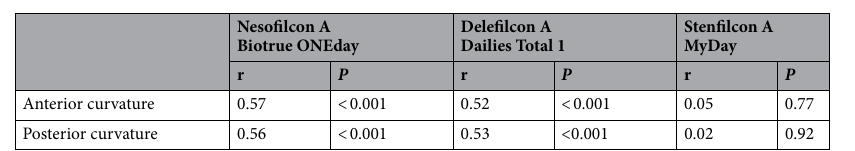
Table 5. Pearson’s correlation coefficient (r) for the mean keratometry value of the cornea and change in the anterior and posterior curvature of the contact